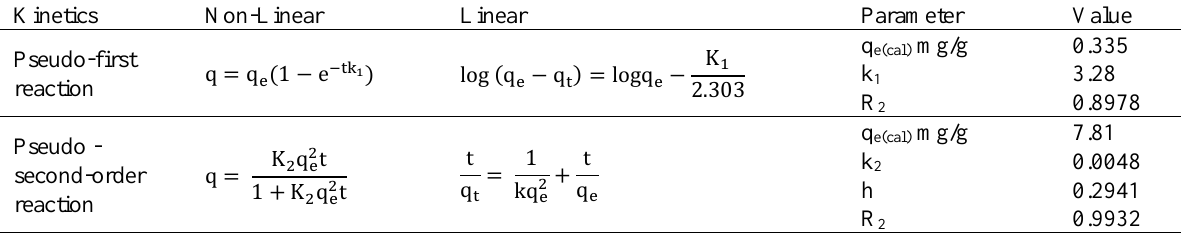
Pseudo - second-order